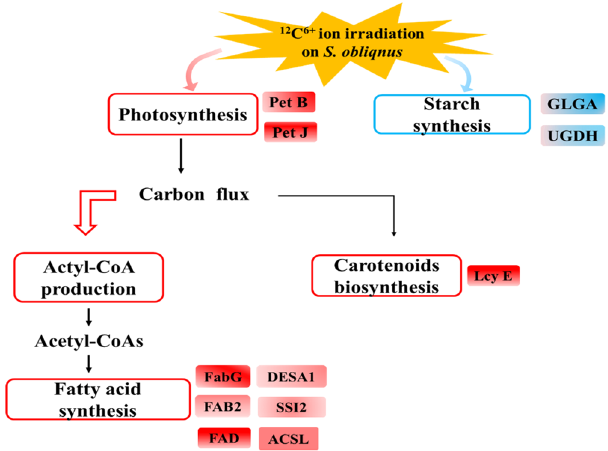
Figure 5. A mechanistic model for 12 C 6+ ion irradiation on S. obliqnus . FabG, 3-oxoacyl-[acyl-carrier protein] reductase; FAB2, SSI2, DESA1, acyl-[acyl-carrier-protein] desaturase; ACSL, long-chain acyl-CoA synthetase; FAD, fatty acid desaturase; Pet B, cytochrome b6; Pet J, cytochrome c6; UGDH, UDPglucose 6-dehydrogenase; GLGA, starch synthase; Lcy E, lycopene epsilon-cyclase. The boxes in red and blue indicate the up- and down- regulated pathways, respectively. Significantly up-regulated and down-regulated genes are shown as the red and blue